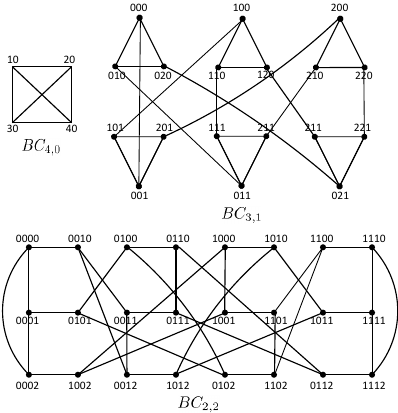
Figure 3. Several transparent BC n , k s with small parameters n and